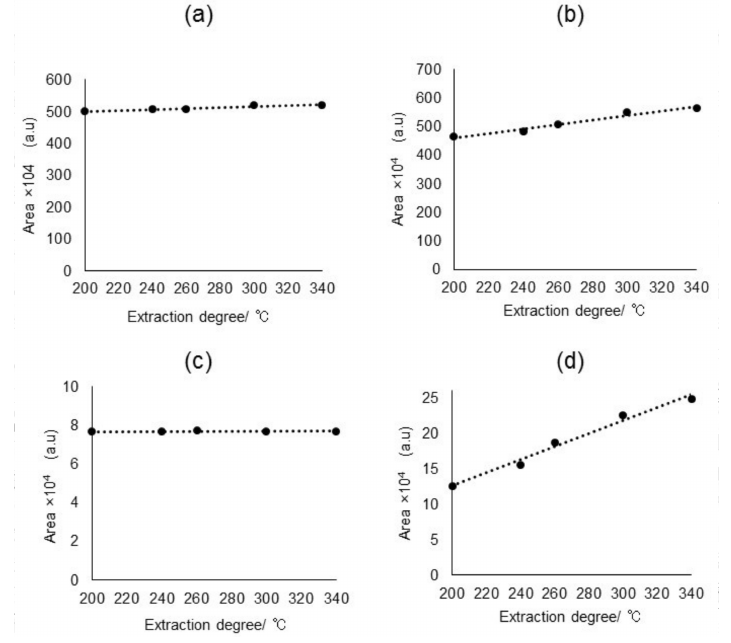
Figure 3. Temperature dependent extraction efficiencies of 1000 mg/kg ( a ) SCCPs; ( b ) DEHP; ( c ) HBCDD, and ( d ) DecaBDE in Py/TD process under a constant GC–MS